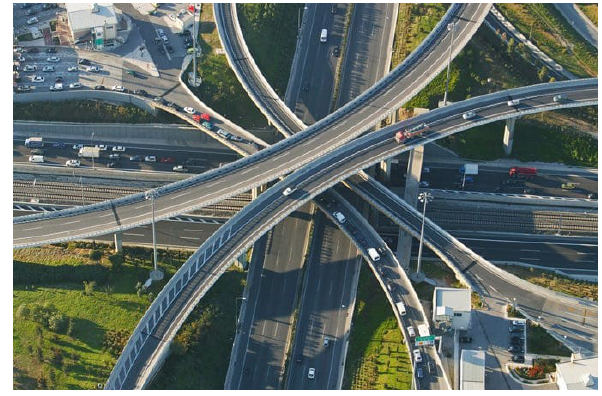
Figure 3: Attiki Odos – The main Athens North Entrance Metamor-